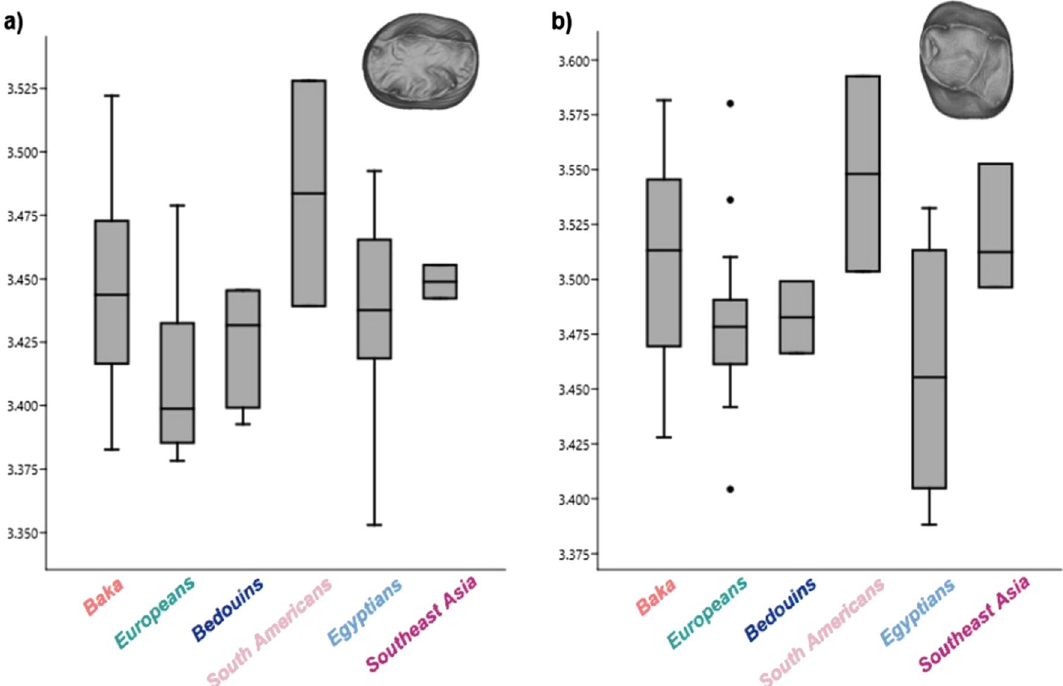
Figure 3. Boxplots of the natural logarithm of Centroid Sizes from the dentinal crown (combining enamel- dentine junction and cervical outline) in deciduous ( a ) lower and ( b ) upper second molars. South Americans and the Baka possess the largest deciduous second molars. The smallest specimens are within the Europeans and Egyptians.